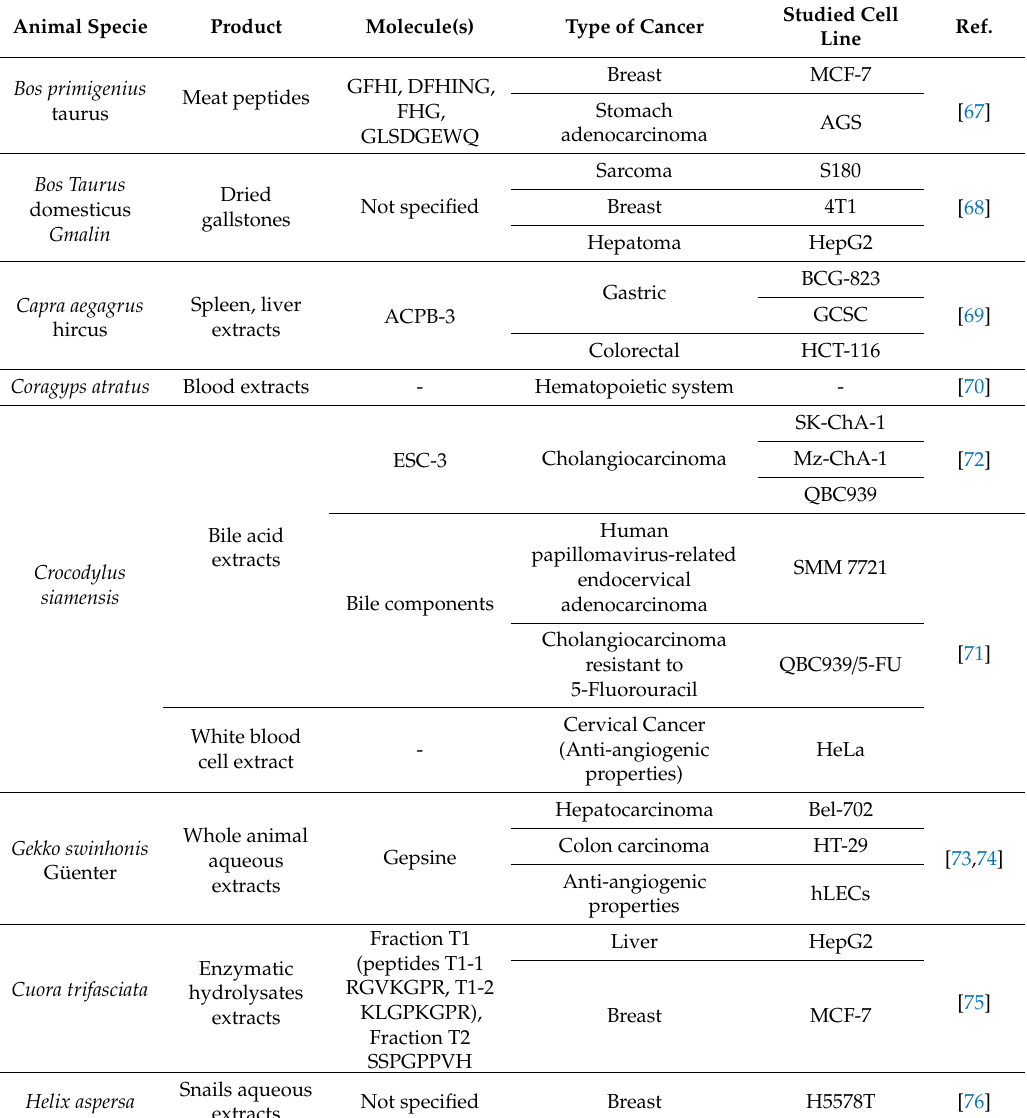
Table 1. Summary of mentioned examples of terrestrial animal anticancer by-products. Abbreviation: Ref,